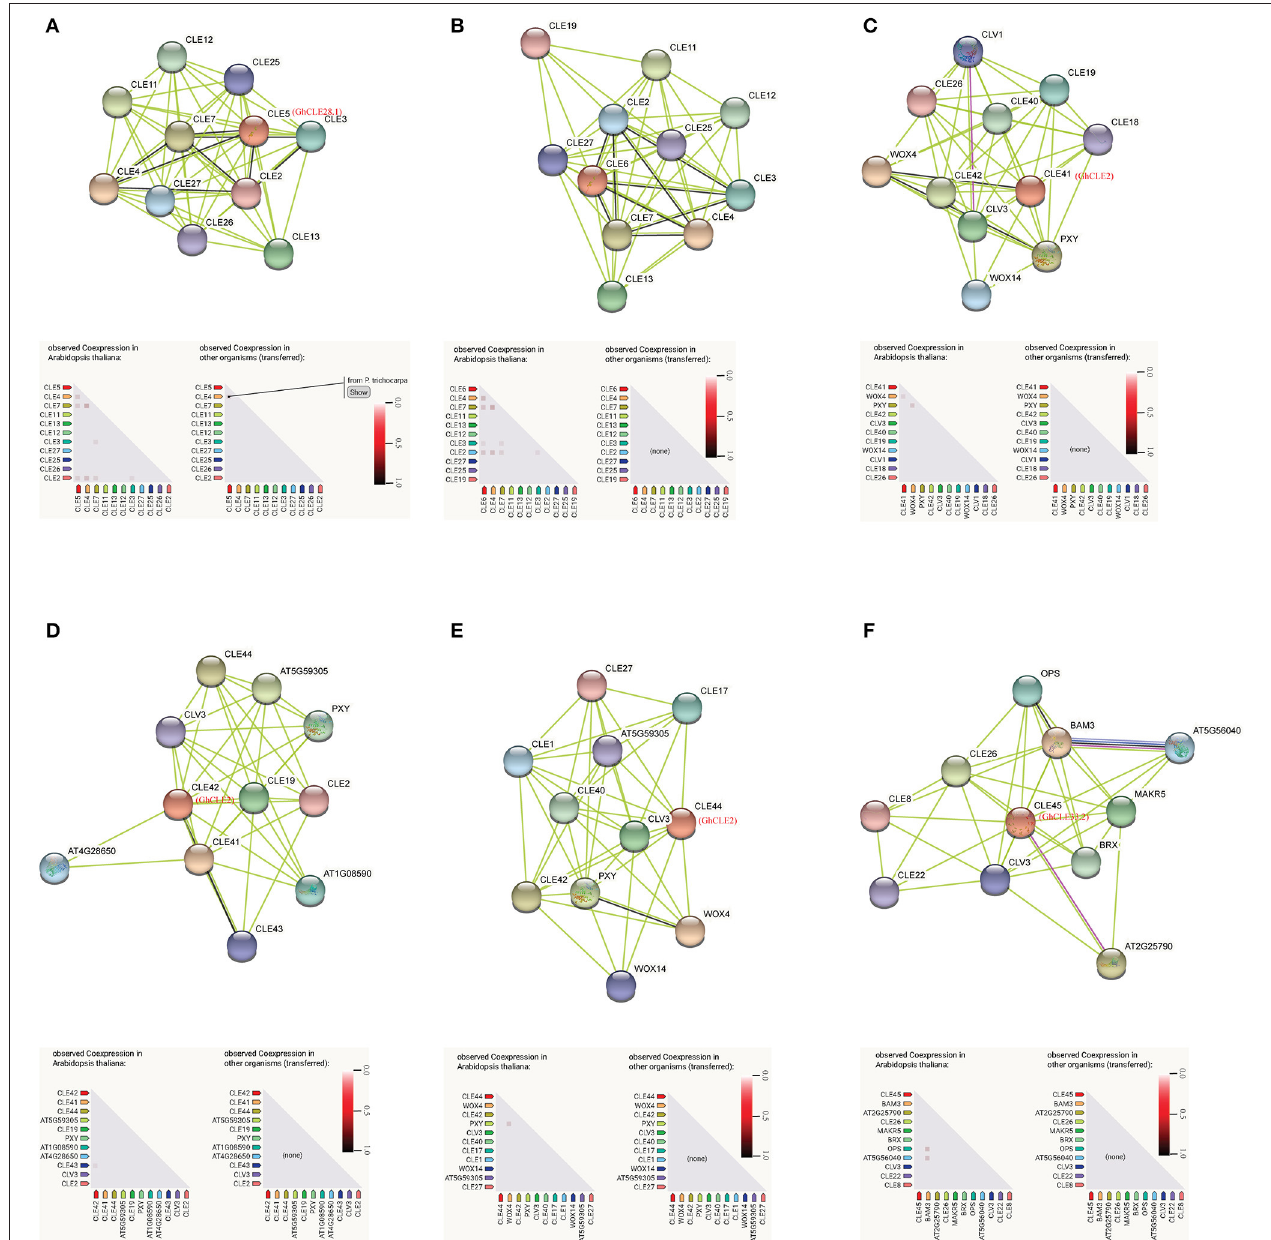
FIGURE 8 | Prediction of interaction network between CLE signal peptide and other related proteins in G. hirsutum , with homologous protein in Arabidopsis as enquiry protein. Homologous proteins of Arabidopsis in G. hirsutum are shown in red. The black line represents the co-expressive relationship. The co-expression predicts functional association under the network diagram: in the triangle matrix, the intensity of the color indicates the level of confidence that two proteins are functionally associated. (A) CLE5; (B) CLE6; (C) CLE41; (D) CLE42; (E) CLE44; (F) CLE45.